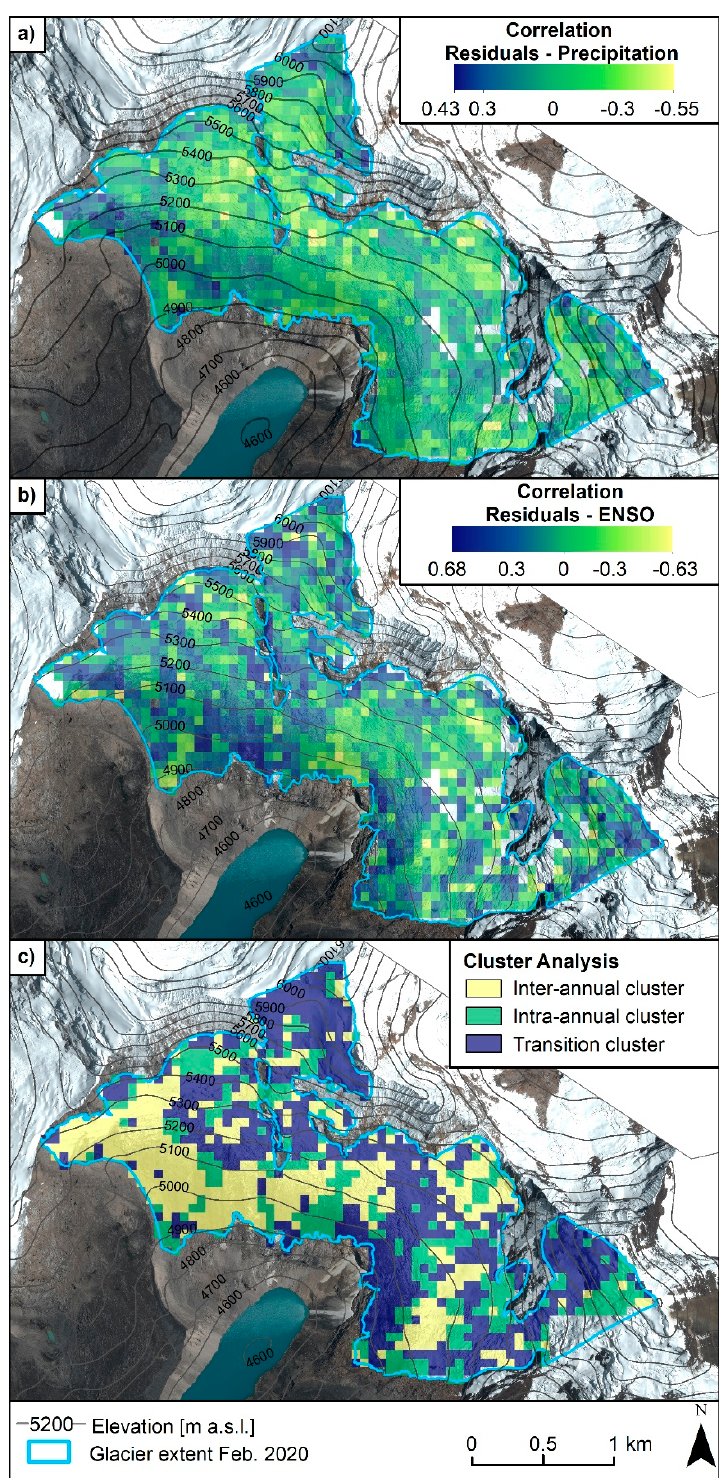
Figure 7. ( a ) Map of correlation coefficients between residuals of the long-term linear fit through the velocity time series and precipitation, measured from the Palcacocha weather station, altitude 4607 m.a.s.l., latitude 09°24’09.3211” S, 77°23’07.0258”, INAIGEM, ( b ) Map of correlation coefficients between residuals of the long-term linear fit through the velocity time series and SST, ( c ) Results of the cluster analysis show the distribution of intra, inter and transitional clusters.